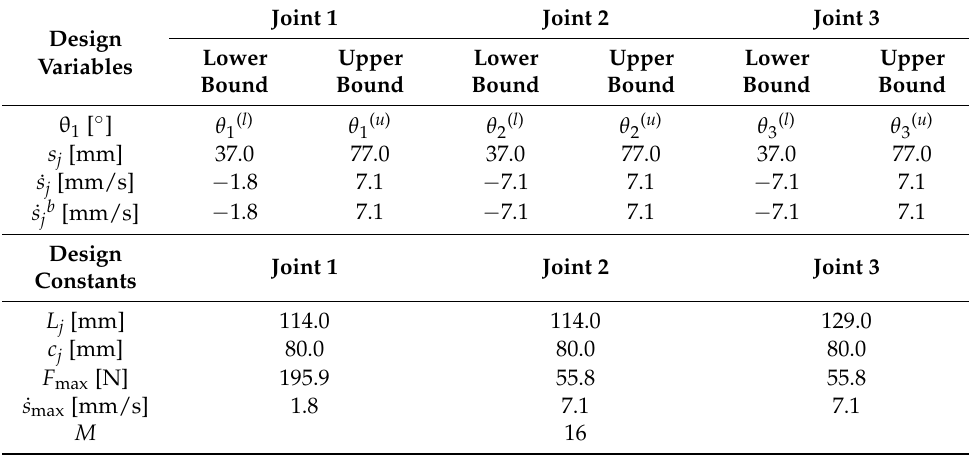
Table 2. Design and control parameters of the DAM-3R.